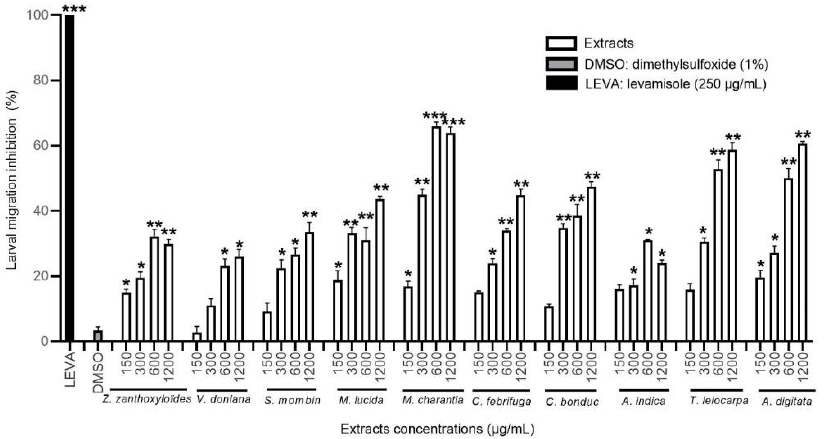
Figure 5. Migration inhibition rate (in %) of H. contortus larvae treated with methanol extracts at different concentrations, DMSO, and levamisole. Asterisks indicate a significant difference compared to the negative control (DMSO) (* p < 0.05, ** p < 0.01, *** p < 0.001). Each histogram represents the mean ± standard deviation from 3 × 3 values.